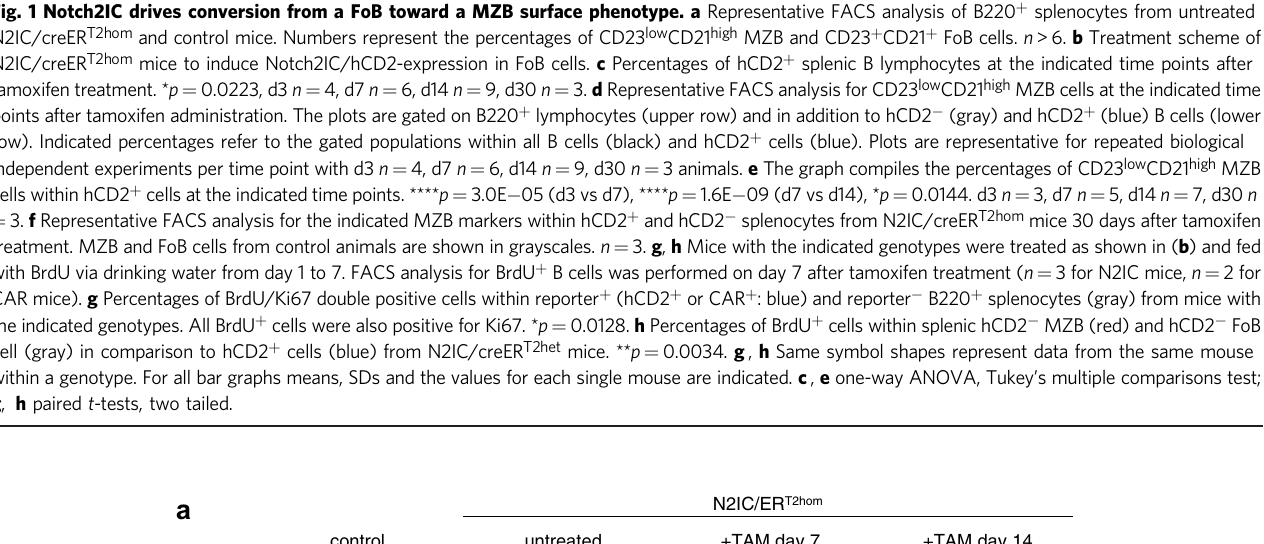
Fig. 1 Notch2IC drives conversion from a FoB toward a MZB surface phenotype. a Representative FACS analysis of B220 + splenocytes from untreated N2IC/creER T2hom and control mice. Numbers represent the percentages of CD23 low CD21 high MZB and CD23 + CD21 + FoB cells. n >6. b Treatment scheme of N2IC/creER T2hom mice to induce Notch2IC/hCD2-expression in FoB cells. c Percentages of hCD2 + splenic B lymphocytes at the indicated time points after tamoxifen treatment. * p = 0.0223, d3 n = 4, d7 n = 6, d14 n = 9, d30 n = 3. d Representative FACS analysis for CD23 low CD21 high MZB cells at the indicated time points after tamoxifen administration. The plots are gated on B220 + lymphocytes (upper row) and in addition to hCD2 − (gray) and hCD2 + (blue) B cells (lower row). Indicated percentages refer to the gated populations within all B cells (black) and hCD2 + cells (blue). Plots are representative for repeated biological independent experiments per time point with d3 n = 4, d7 n = 6, d14 n = 9, d30 n = 3 animals. e The graph compiles the percentages of CD23 low CD21 high MZB cells within hCD2 + cells at the indicated time points. **** p = 3.0E − 05 (d3 vs d7), **** p = 1.6E − 09 (d7 vs d14), * p = 0.0144. d3 n = 3, d7 n = 5, d14 n = 7, d30 n = 3. f Representative FACS analysis for the indicated MZB markers within hCD2 + and hCD2 − splenocytes from N2IC/creER T2hom mice 30 days after tamoxifen treatment. MZB and FoB cells from control animals are shown in grayscales. n = 3. g , h Mice with the indicated genotypes were treated as shown in ( b ) and fed with BrdU via drinking water from day 1 to 7. FACS analysis for BrdU + B cells was performed on day 7 after tamoxifen treatment ( n = 3 for N2IC mice, n = 2 for CAR mice). g Percentages of BrdU/Ki67 double positive cells within reporter + (hCD2 + or CAR + : blue) and reporter − B220 + splenocytes (gray) from mice with the indicated genotypes. All BrdU + cells were also positive for Ki67. * p = 0.0128. h Percentages of BrdU + cells within splenic hCD2 − MZB (red) and hCD2 − FoB cell (gray) in comparison to hCD2 + cells (blue) from N2IC/creER T2het mice. ** p = 0.0034. g , h Same symbol shapes represent data from the same mouse within a genotype. For all bar graphs means, SDs and the values for each single mouse are indicated. c , e one-way ANOVA, Tukey ’ s multiple comparisons test; g , h paired t -tests, two tailed.